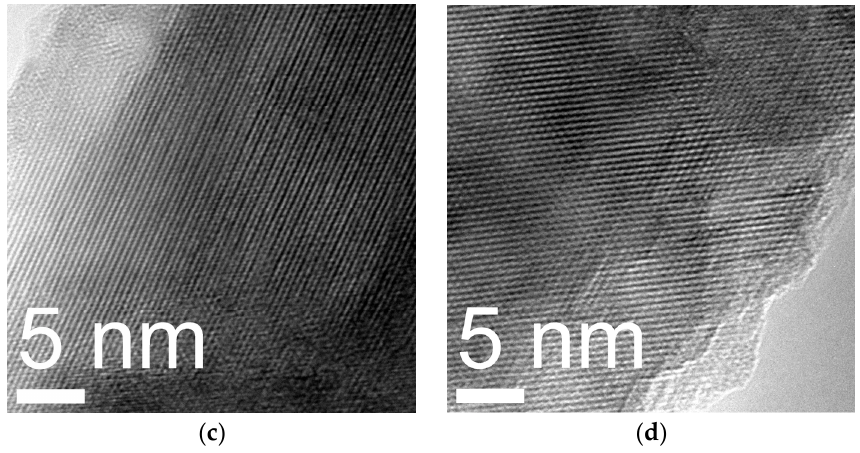
Figure 6. HRTEM images of gallium oxide nanoplates synthesized using ( a ) no surfactant and precursor:surfactant:solvent ratio as follows: ( b ) 1:1.6:740; ( c ) 1:3.2:740; and ( d ) 1:4.8:740.